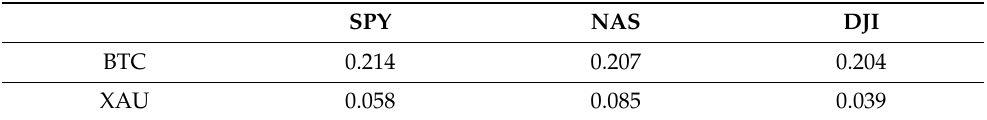
Table 6. Correlation Table for the Period from October 2017 to July